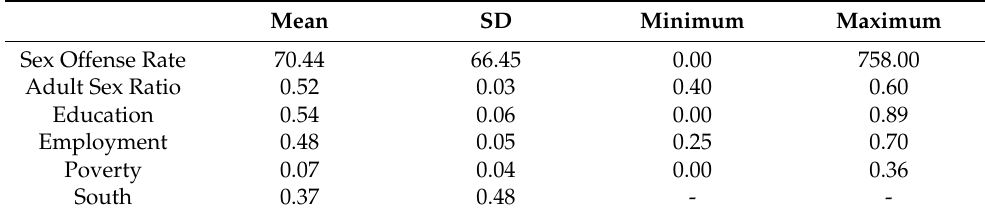
Table 1. Descriptive statistics ( n =